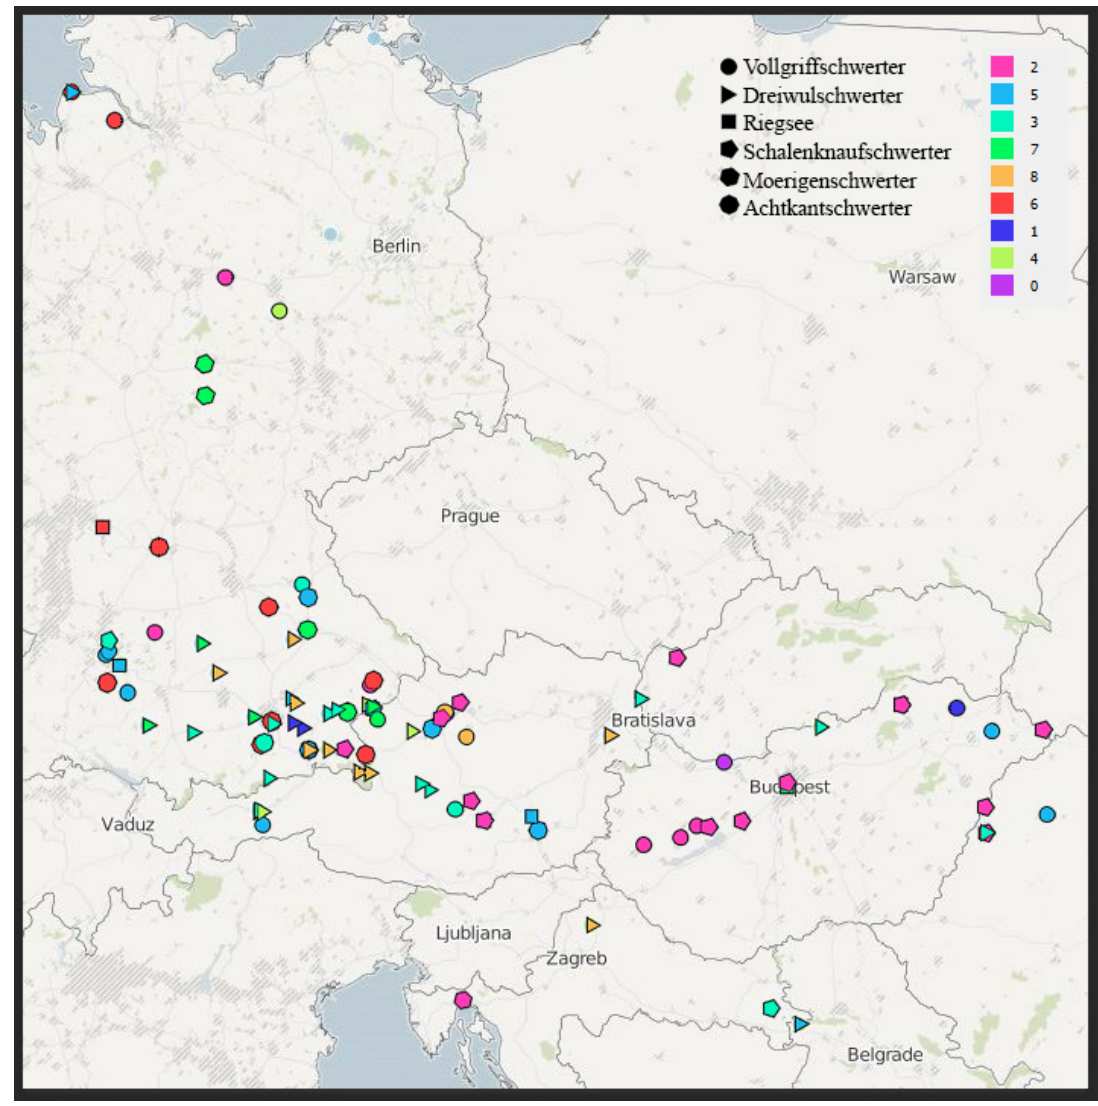
Figure 15. Communities mapped geographically. Colors represent the sub community in the network and shapes represent style